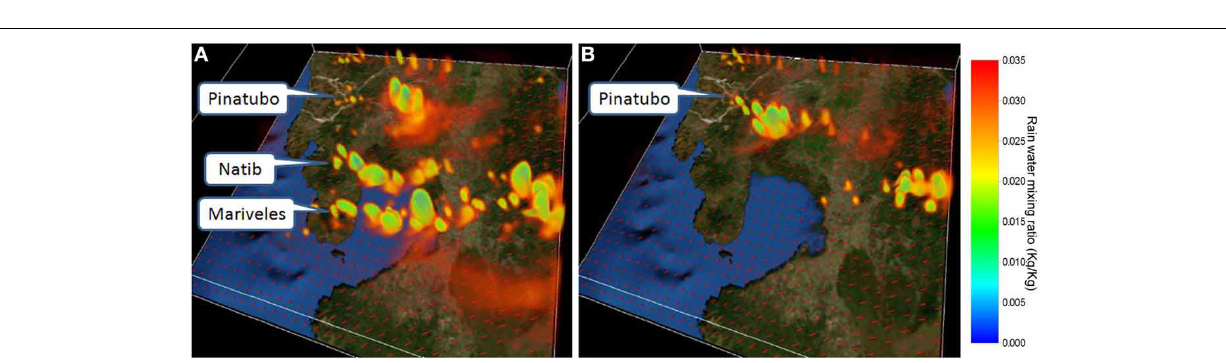
FIGURE 7 | Snapshot in time of the simulated accumulated rain water mixing ratio for (A) case 1 and (B) case 2 from 19 August 2013 00Z to 19 August 2013 00Z. The vectors represent the wind